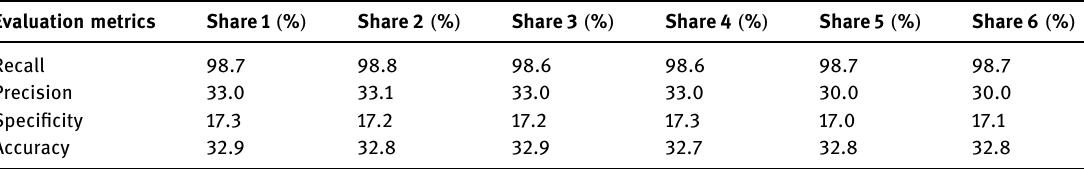
Table 4: Results of objective evaluation metrics Evaluation metrics